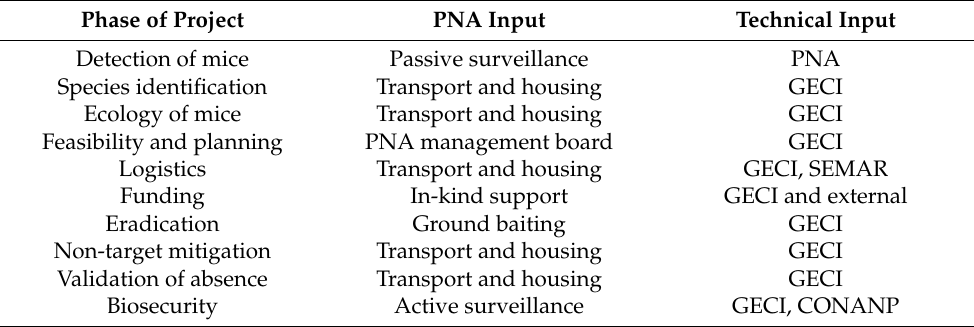
Table 1. PNA’s involvement at the different stages of the mouse eradication on San Benito Oeste Island.